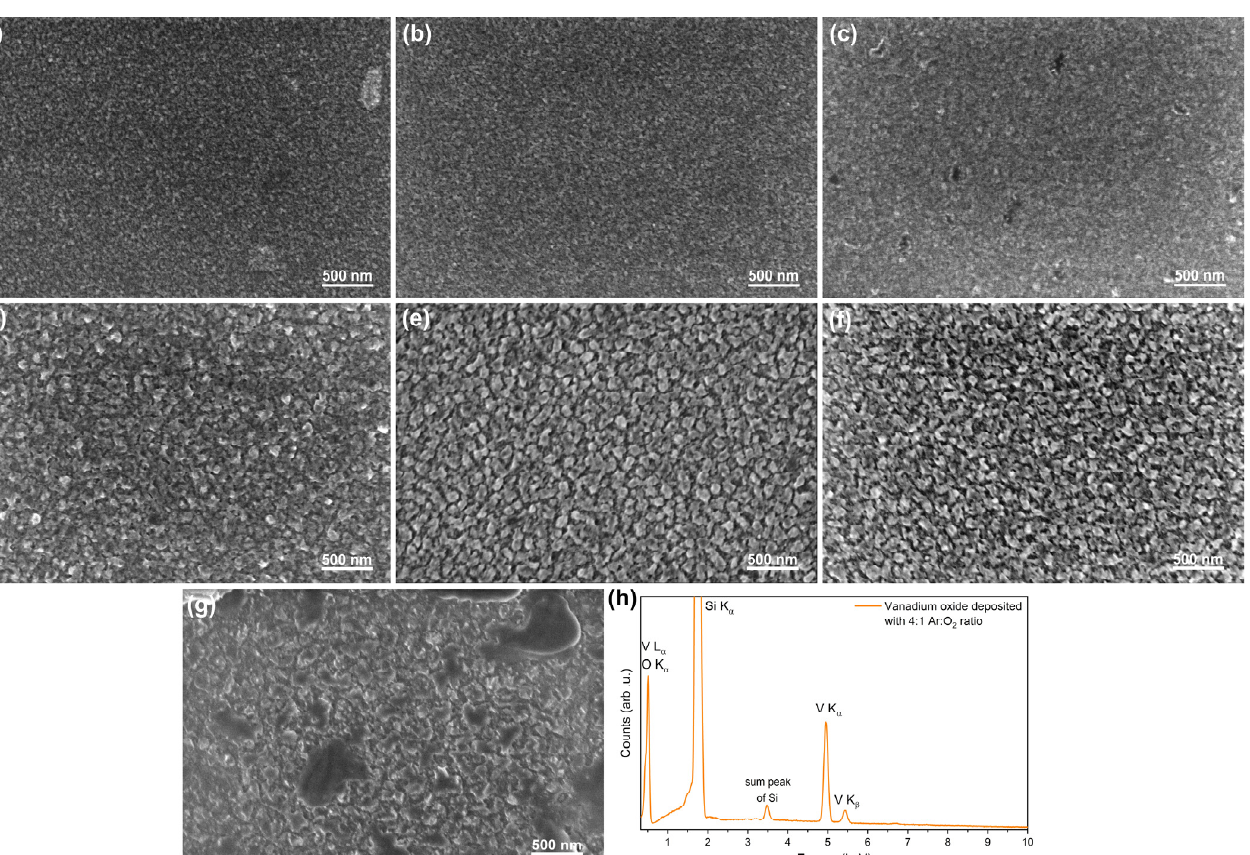
Figure 2. Diffraction patterns of vanadium oxides deposited with various Ar:O 2 gas ratios.